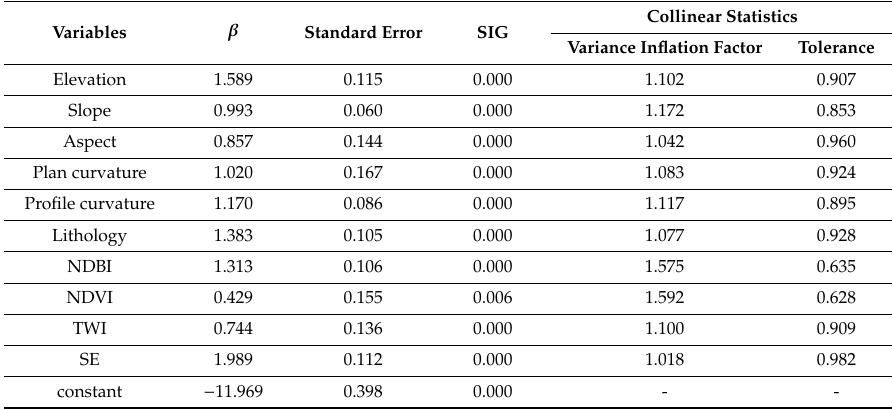
Table 2. Parametric statistics in the soil erosion–logistic regression (SE_LR) model with 30 m grid